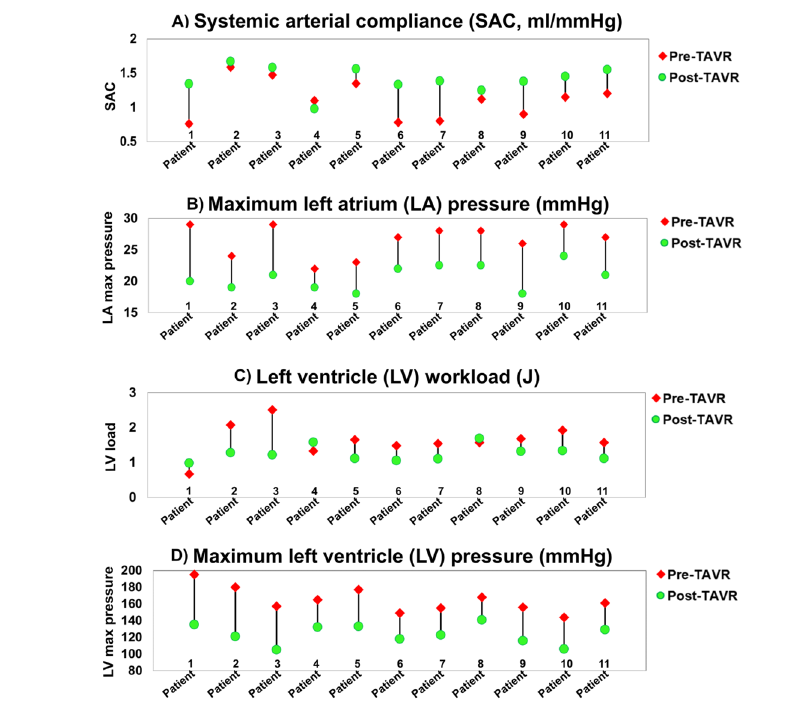
Figure 6. Changes in global hemodynamics (metrics of circulatory function & metrics of cardiac function) in patients between baseline and 90-day post-TAVR (N = 11). ( a ) Systemic arterial compliance; ( b ) Maximum left atrium pressure; ( c ) Left ventricle workload; ( d ) Maximum left ventricle pressure. Global hemodynamics : (1) Metrics of circulatory function, e.g., detailed information of the dynamics of the circulatory system, and (2) Metrics of cardiac function, e.g., heart workload and the breakdown of workload contributions from each cardiovascular disease